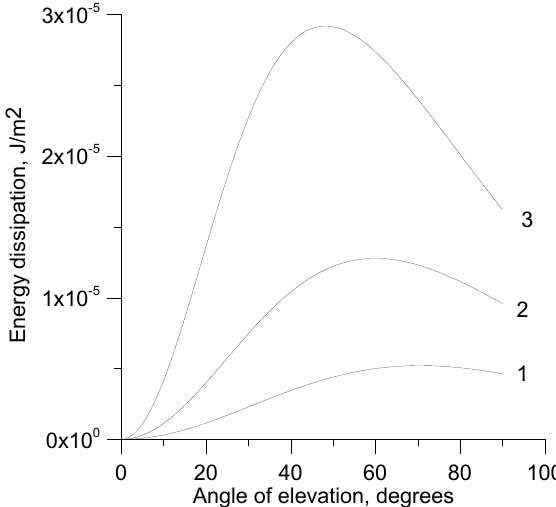
Figure 5. The energy transmitted radially across a unit area at different elevation angles at a distance of 100 km by a half sinusoidal current waveform carrying a charge of 5 C. The results are shown for three current propagation speeds. (1) u =1.0 × 10 8 m/s. (2) u =1.5 × 10 8 m/s. (3) u = 2.0 × 10 8 m/s.